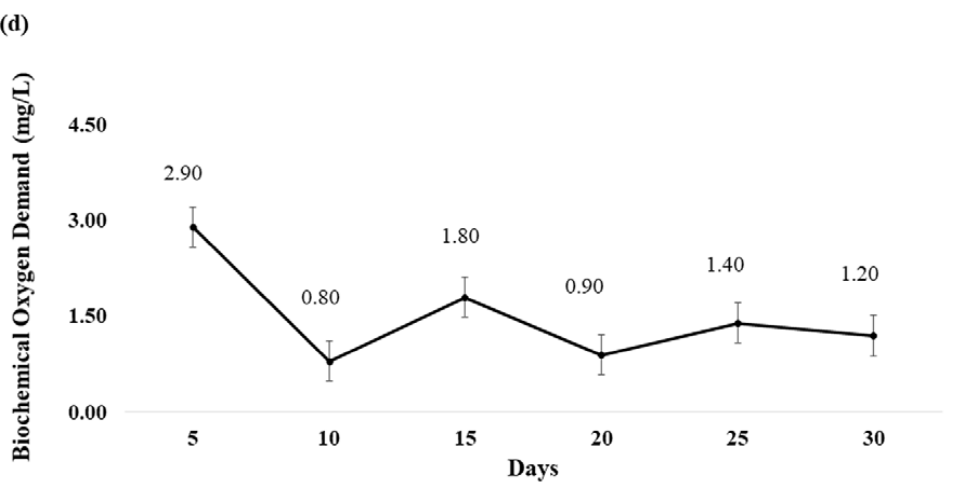
Figure 6. ( a ) The overall pH of the natural outdoor pond water during the 30 days of immersion period. The data are presented as mean ± standard deviation while data in the parentheses () indicate the range values; ( b ) The overall maximum daily ambient temperature of the natural outdoor pond water during the 30 days of immersion period. The data are presented as mean ± standard deviation while data in the parentheses () indicate the range values; ( c ) The overall turbidity of the natural outdoor pond water during the 30 days of immersion period. The data are presented as mean ± standard deviation while data in the parentheses () indicate the range values; ( d ) The overall biochemical oxygen demand of the natural outdoor pond water during the 30 days of immersion period. The data are presented as single values obtained during every 5 ‐ day interval of analysis.